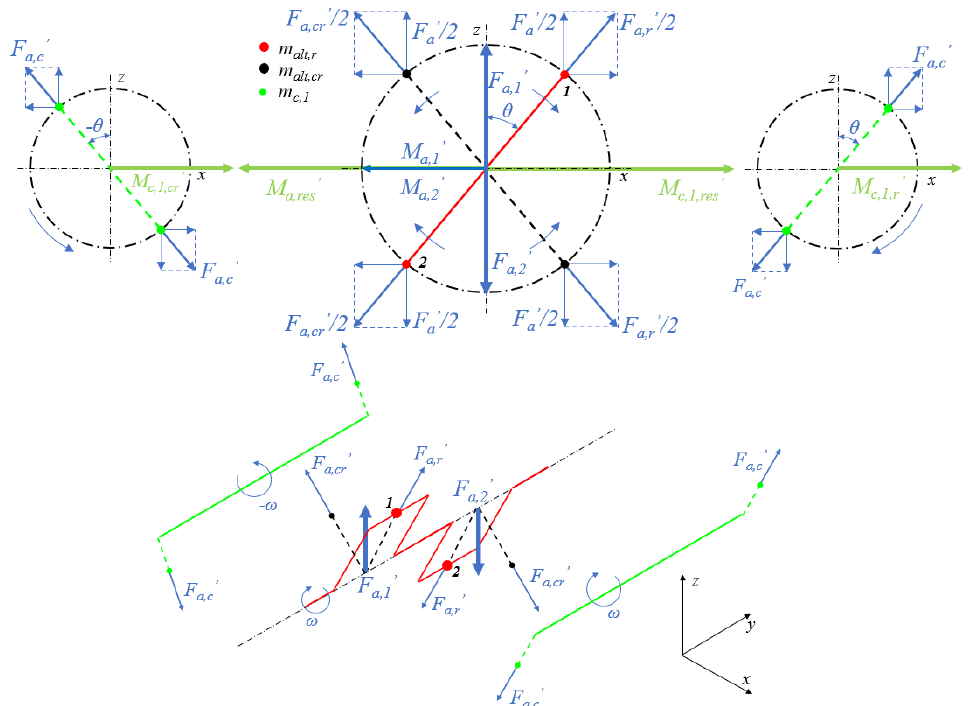
Figure 3. Polar plot and relative isometry of the crankshaft for a 2 cylinder in-line engine with a 180° angle between cranks, including the primary reciprocating forces equilibrium and the additional primary balancing